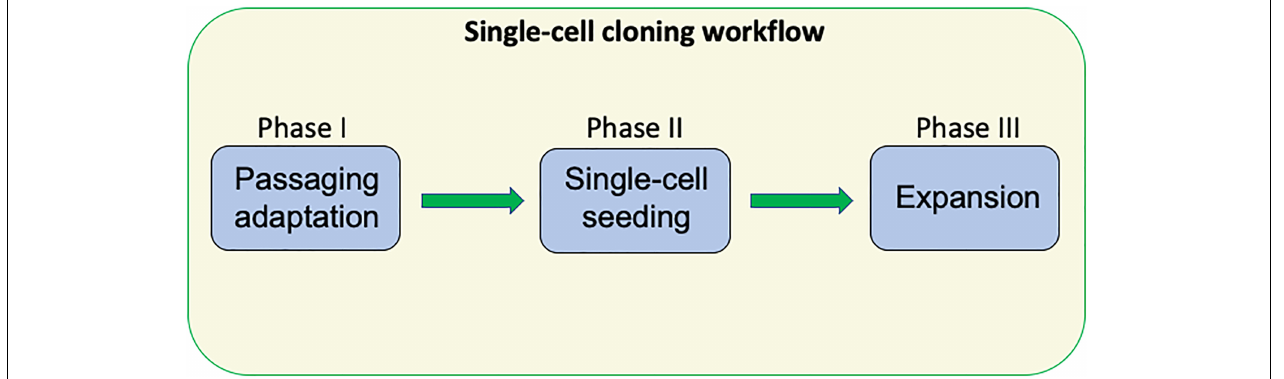
FIGURE 1 | The overall scheme for efficient single-cloning of hPSCs. This approach consists of three phases and routinely results in efficiencies of ∼ 40%.